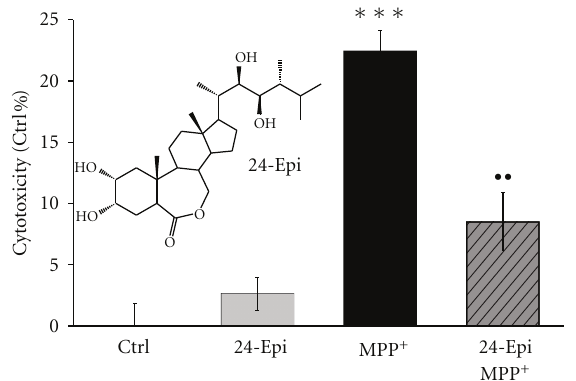
Figure 2: E ff ect of 24-Epi against MPP + -induced cytoxicity in neuronal PC12 cells, as measured by colorimetric assay based on LDH activity. Neuronal cells were pretreated with 24-Epi (10 − 9 M) or vehicle for 3h and then exposed to MPP + (5mM) or not for 24h. The absorbance value obtained for the untreated control was subtracted from all other values, as described in Section 2. Data are expressed as percentages of values of untreated control cells and are means ± S.E.M. n = 3. ∗∗∗ P < . 001 versus Ctrl and •• P < . 01 versus MPP +